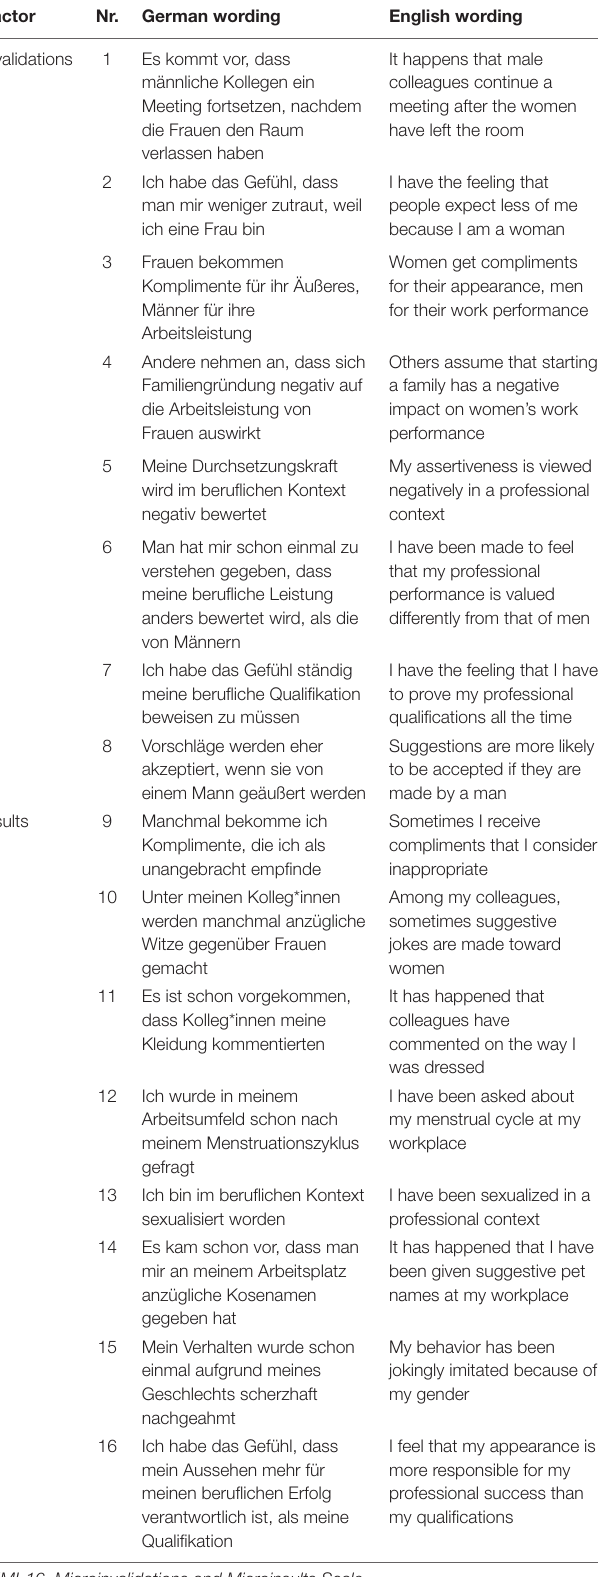
TABLE 1 | Items of the